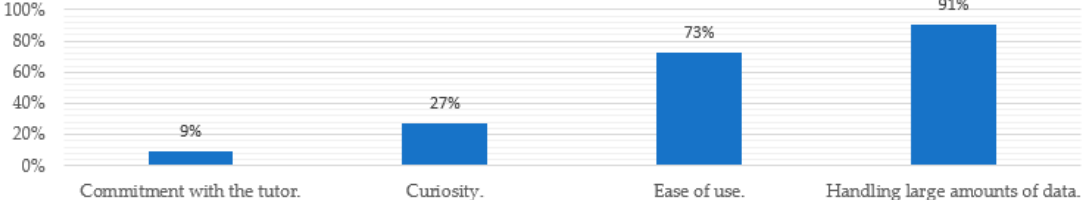
Figure 10. Reasons for using the DSS and considering it useful.